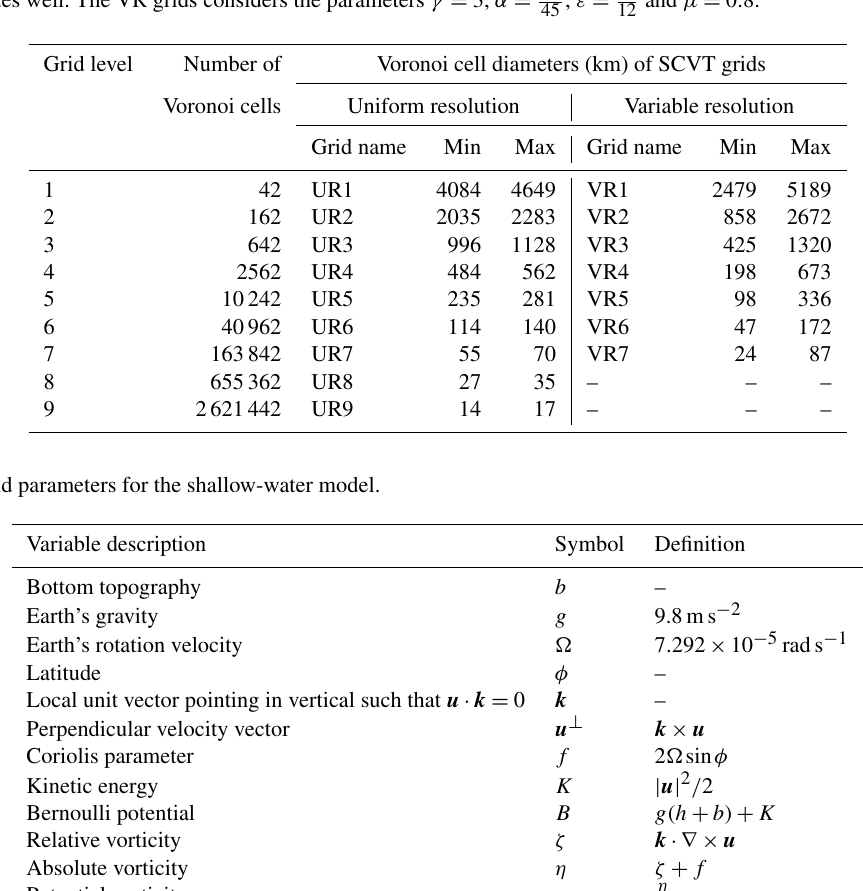
Table 1. Minimum and maximum diameters of the Voronoi cells for the uniform SCVT grid (UR) and for the variable-resolution (VR) grid that captures the Andes well. The VR grids considers the parameters γ = 3, α = 7 π